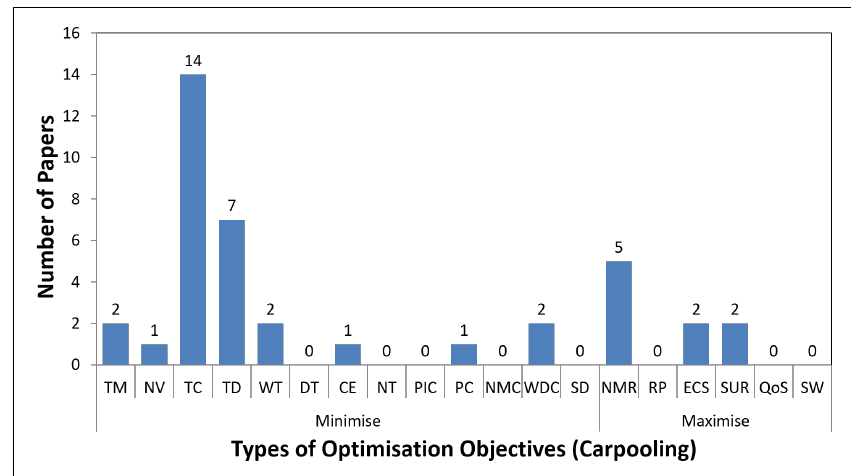
Figure 15. Distribution of Papers based on the Optimisation Objectives: Carpooling.